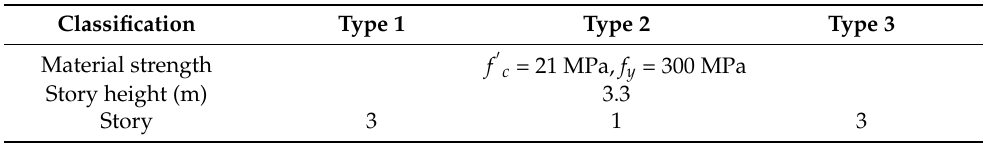
Table 1. Overview of analysis